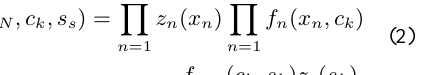
Figure 2: Factor graph model (independent model; a mixture la- tent variable is employed) for hyperspectral data classification The factor graph is described as: